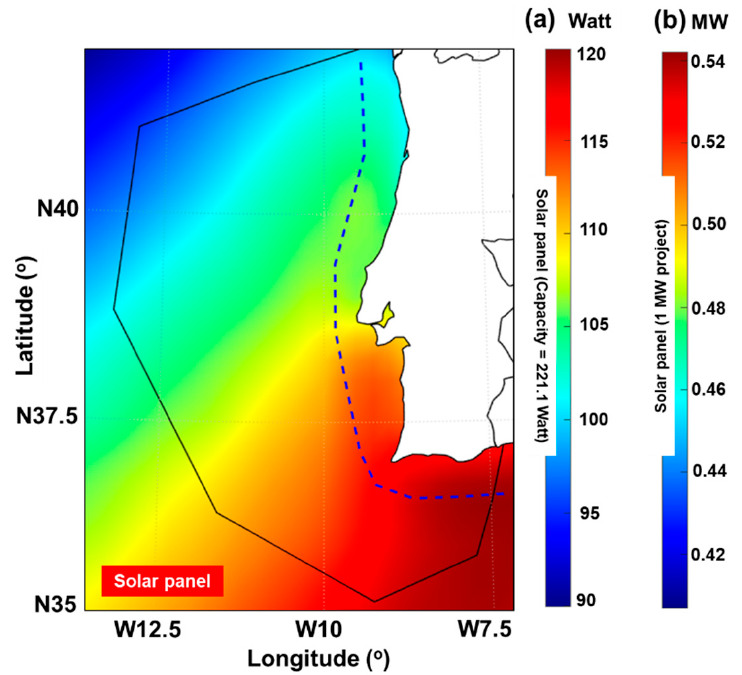
Figure 10. Expected power output from a solar panel operating in the Portuguese coastal area, where: ( a ) performance related to a single panel (221.1 Watt); ( b ) equivalent output of a 1 MW solar project.